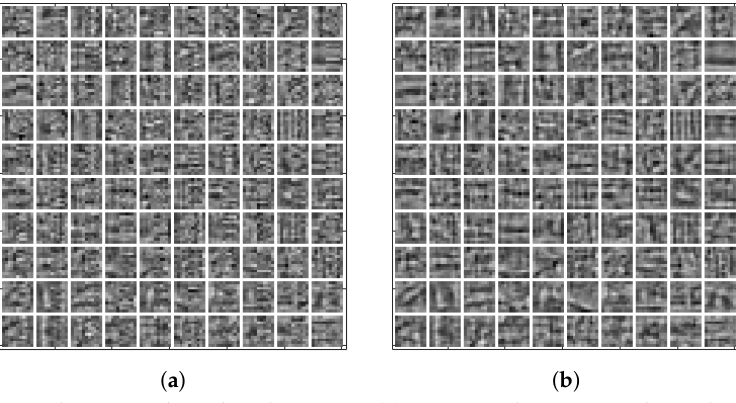
Figure 3. Proposed Retinex algorithm dictionary; ( a ) Our CSC dictionary in large datasets, ( b ) Our SVD-CSC dictionary in large